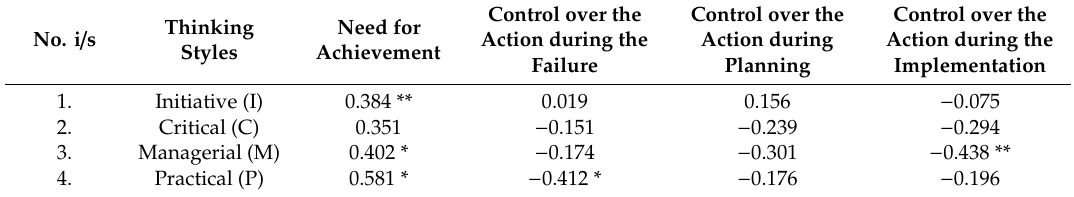
Table 2. Table of correlation relations of thinking style and motivational tendencies in Group